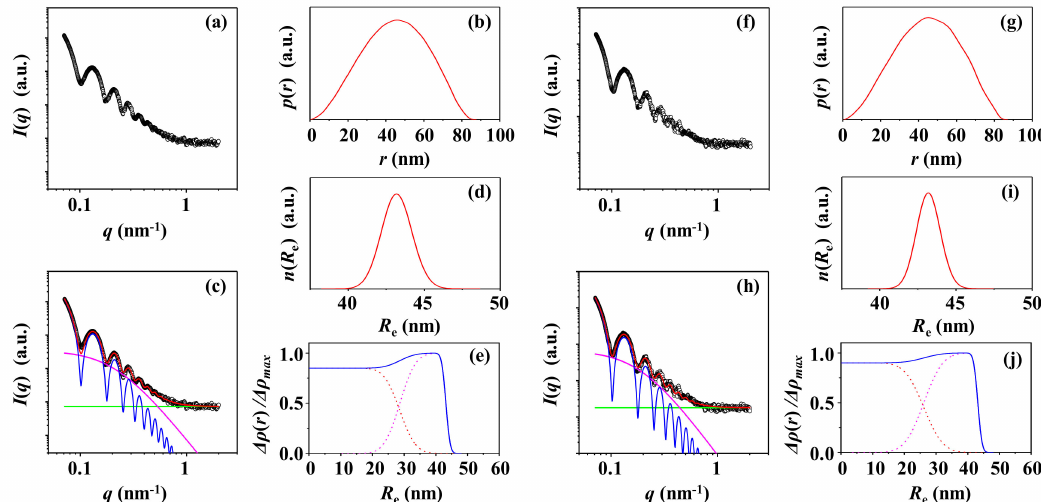
Figure 1. X-ray scattering analysis of PS-1. ( a ) SAXS profile measured at room temperature and corrected for water as the solution medium: ( b ) pair distance distribution functions p ( r ) obtained from the scattering profile using the IFT method; ( c ) data analysis results; ( d ) radius distribution obtained by the data analysis in ( c ); ( e ) density distribution obtained by the data analysis in ( c ). ( f ) SAXS profile measured at room temperature and corrected for the supernatant as a solution medium: ( g ) pair distance distribution functions p ( r ) obtained from the scattering profile using the IFT method; ( h ) data analysis results; ( i ) radius distribution obtained by the data analysis in ( h ); ( j ) density distribution obtained by the data analysis in ( h ). ( c , h ) the open symbols are the measured data and the red solid line represents the sum of the profiles obtained by fitting the data using two-phase ellipsoid model (blue line) and local random two-phase contributions (purple line) and the background (green